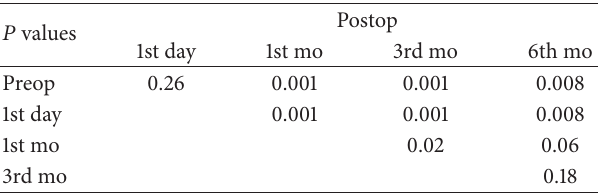
Table 2: Statistical significance in the comparison of BVCA mea- surements without CME.